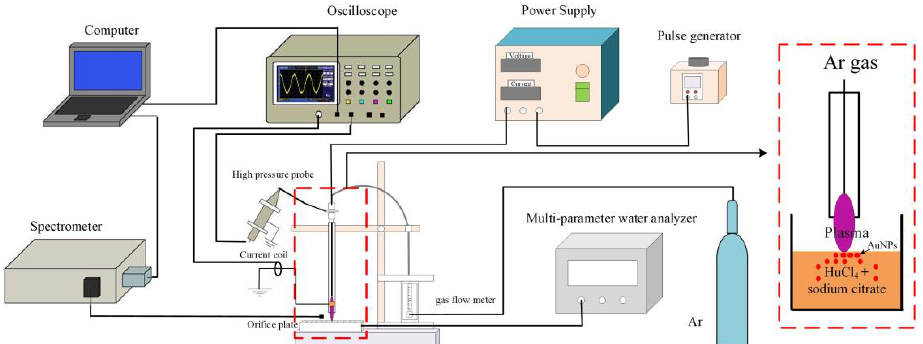
Figure 1. A schematic diagram of the plasma jet setup used for AuNP synthesis (inset shows enlarged diagram of plasma jet–liquid system).